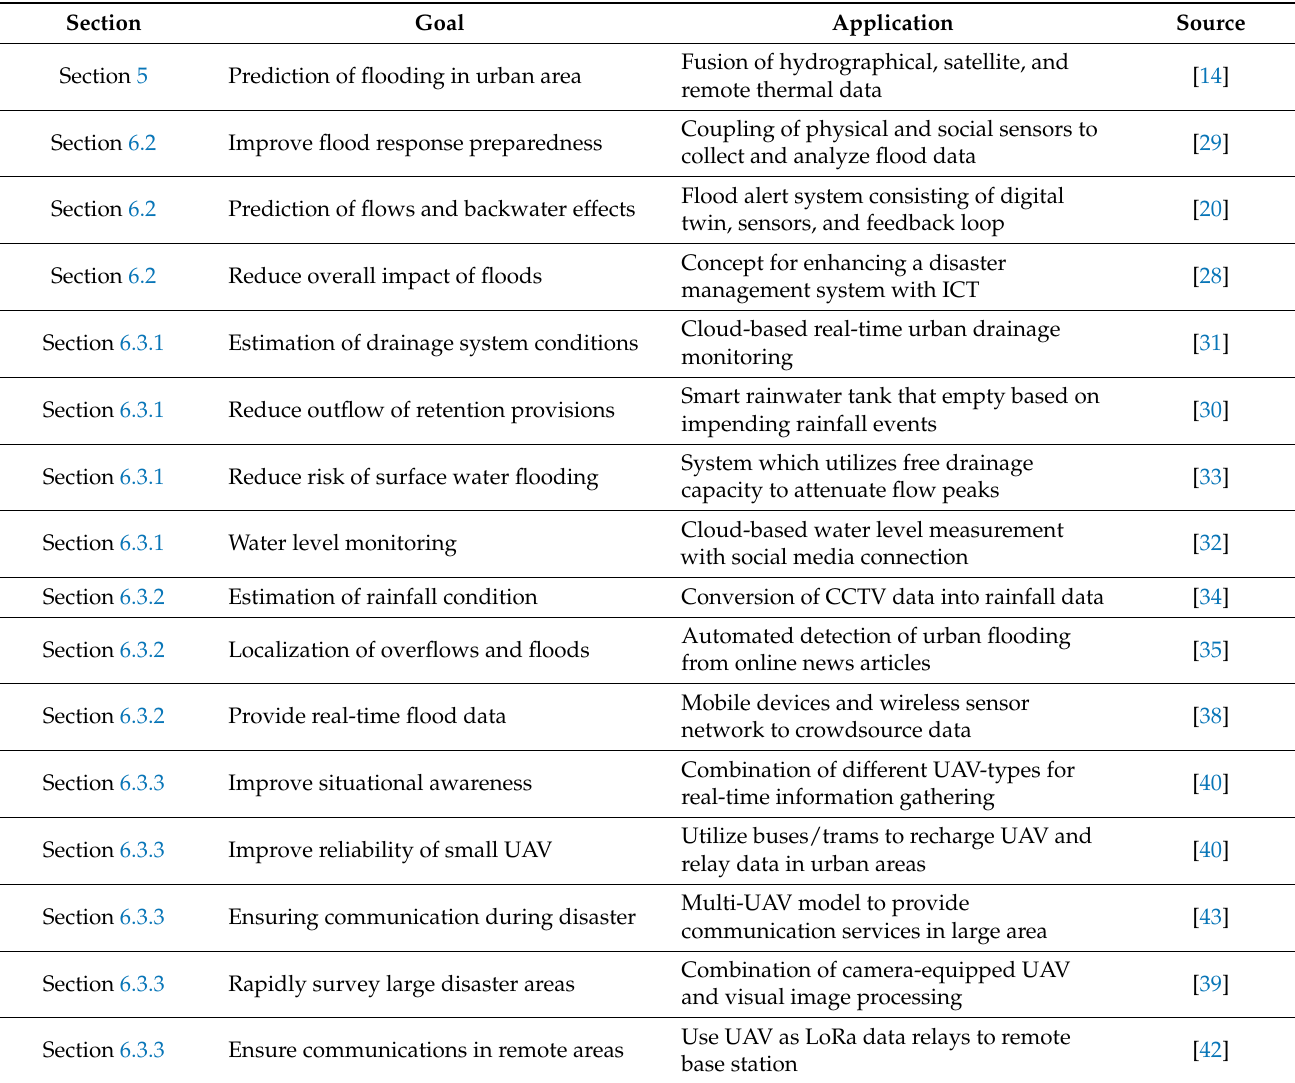
Table 3. Selected smart city solutions for management of water-based